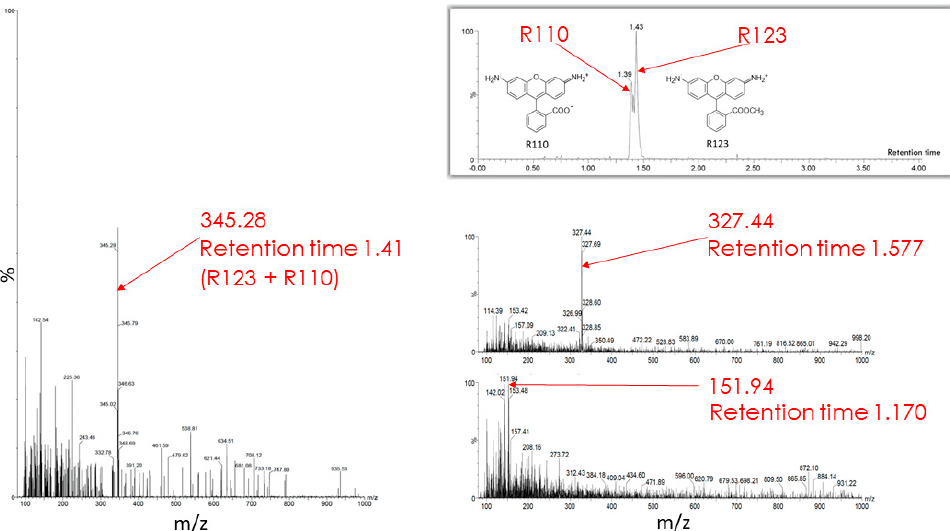
Figure 7. Mass spectrometry of butanol extracts of glioma cells after their cultivation with Rh123 (2 µM) for 2 h. The two factions are resolved with retention times on the column of 1.39 and 1.43 min and a clear predominance of the second component corresponding to Rh123 over the first one corresponding to Rh110 (shown on left spectrum with the mass/charge of 345.28 corresponding to the mixture of Rh123 and 110). Two minor components were detected with retention times of 1.577 and 1.170 min with the main peaks in of mass/charge ( m / z ) values of 327 and 152, respectively (two spectra on the right).